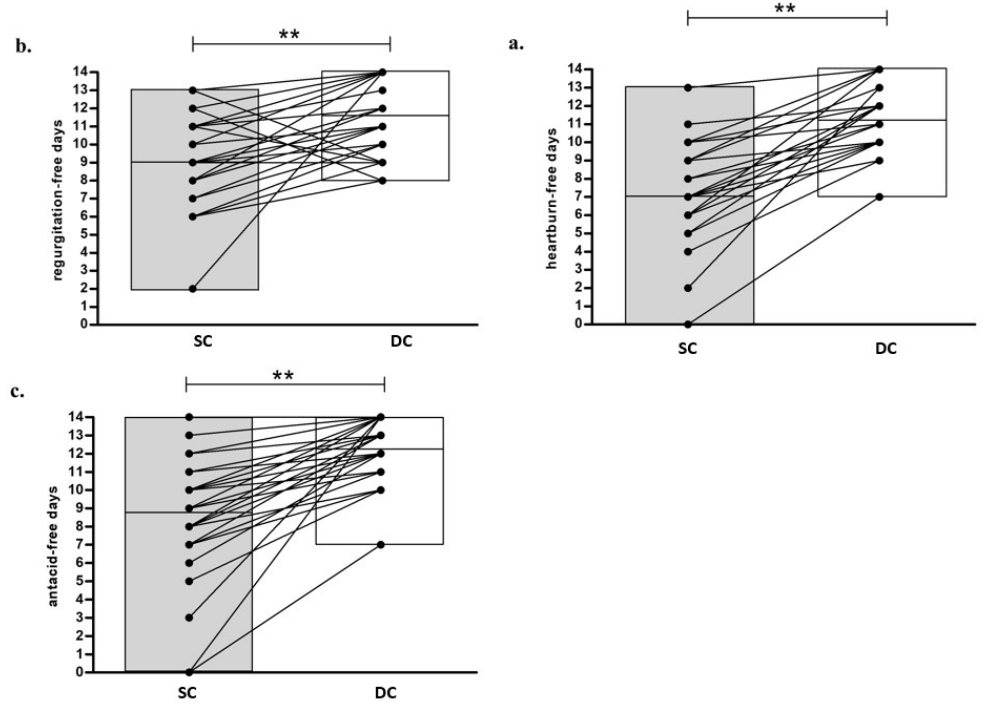
Figure 2. Evaluation of heartburn-free days ( a ), regurgitation-free days ( b ) and antacid-free days ( c ) during both treatment periods ( n = 40). DC, Dewaxed Coffee; SC, Standard Coffee. ** p < 0.01. Table 5. PAGI-SYM, PAGI-QoL and IBS-SSS total scores changes in basal conditions and during SC and DC Treatment Periods. Data are presented as mean ± SD.